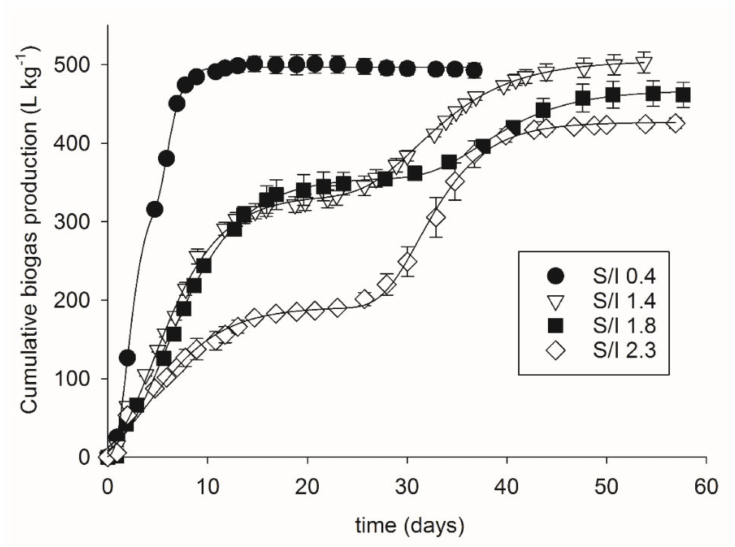
Figure 3. Cumulative biogas production and two-phase Gompertz simulation (line) using gelatin as substrate with different substrate to inoculum ratios (S/I) in agitated bioreactors.